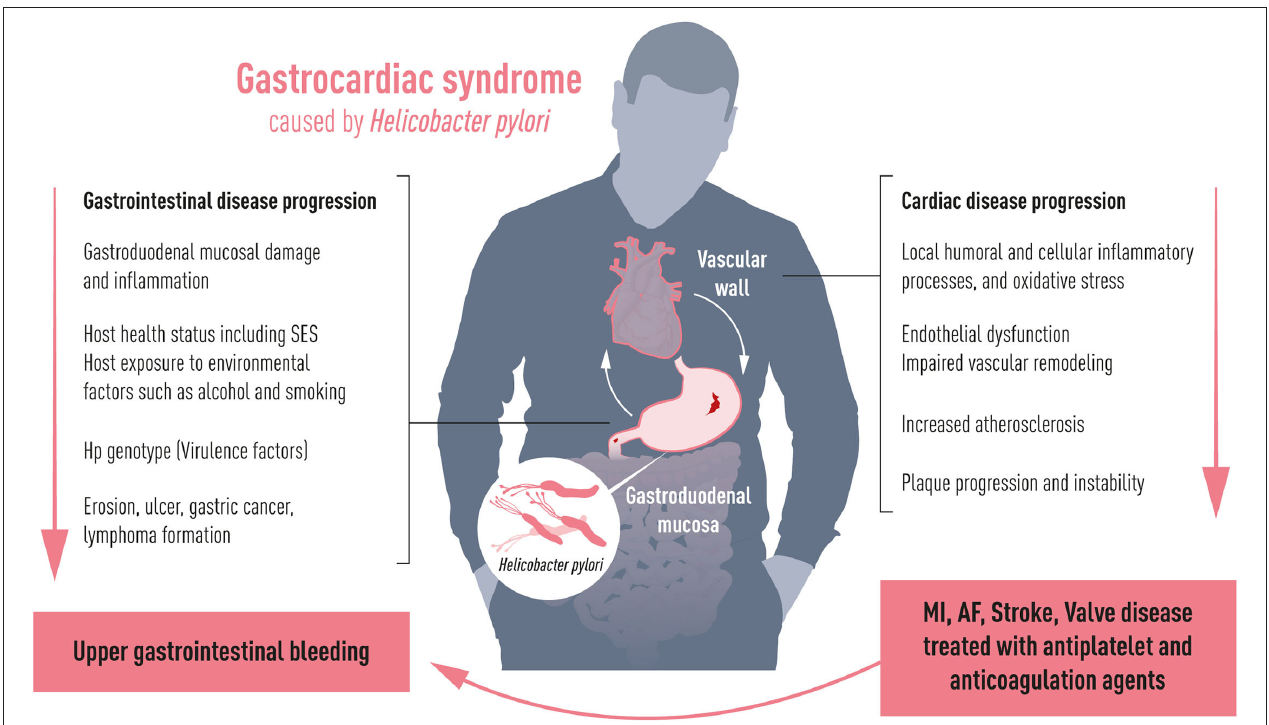
FIGURE 1 | Gastrocardiac syndrome. Depending on host health including socioeconomic status (SES) and virulence factors, Helicobacter pylori affects the gastric mucosa causing gastroduodenal lesions with the risk to develop bleeding complications. Simultaneously, it induces chronic inflammation to the vascular wall affecting progress and degree of cardiovascular disease such as stroke, myocardial infarction (MI), atrial fibrillation (AF) and valvular heart disease. Cardiovascular diseases are commonly treated with antithrombotic drugs, which aggravate the risk of upper gastrointestinal